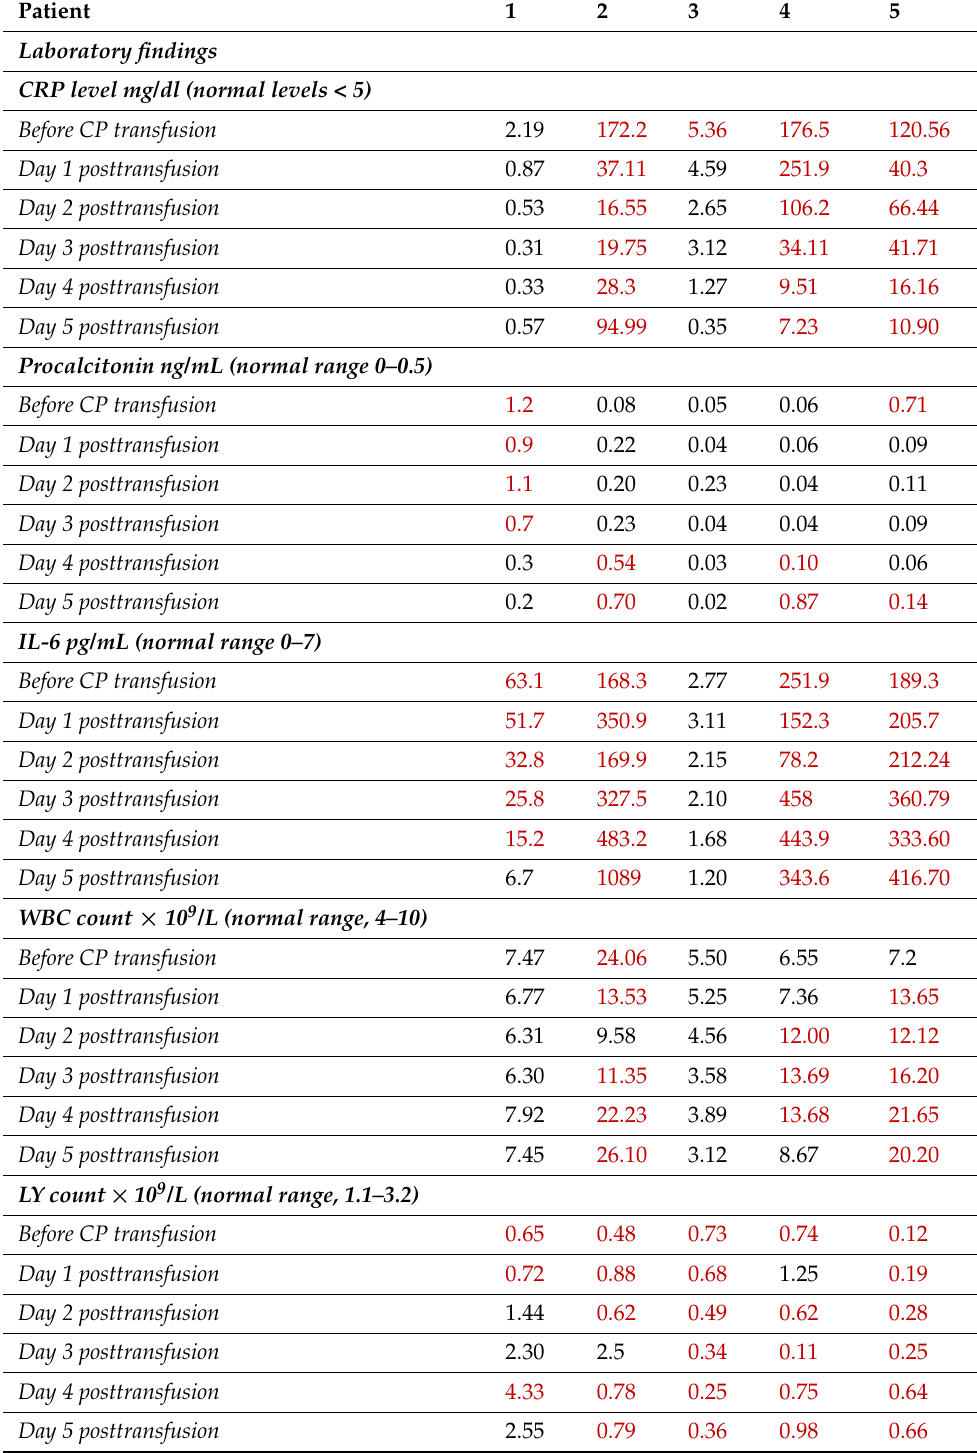
Table 2. Laboratory results before and after CP